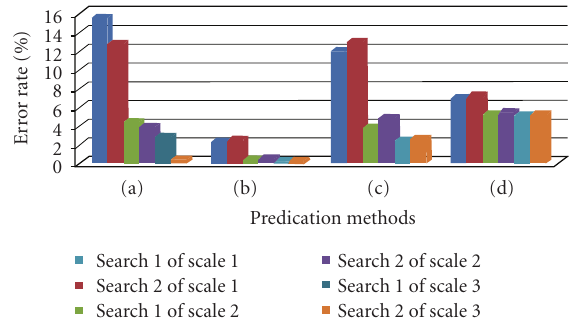
Figure 14: Prediction error rate of di ff erent methods for the execu- tion time presented in Figure